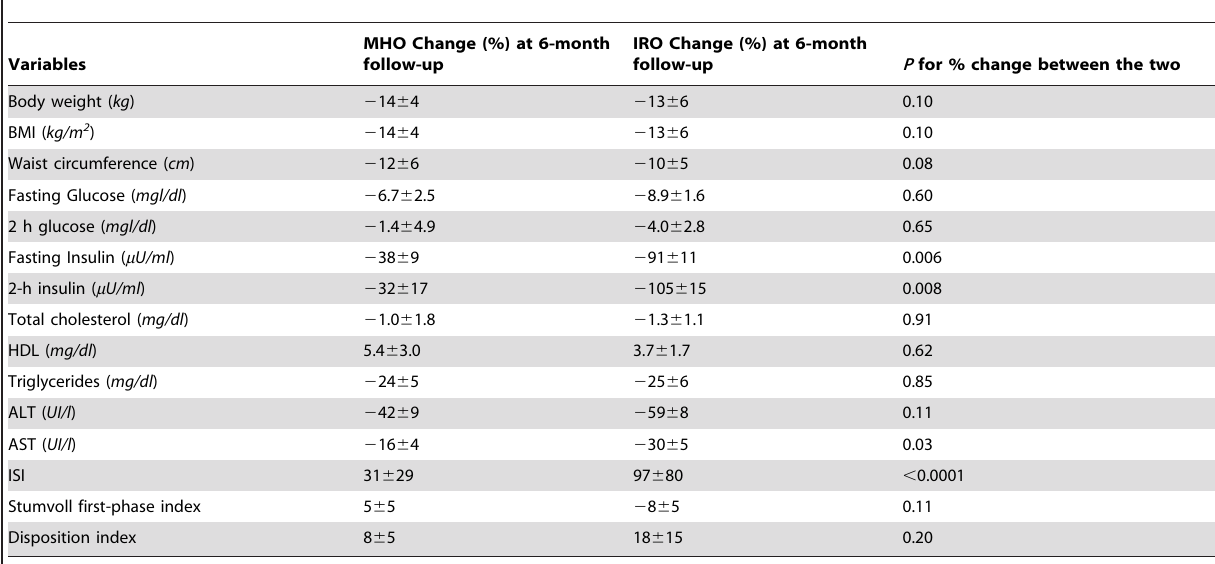
Table 2. Change (%) in clinical characteristics and laboratory data at 6-month follow-up after LAGB intervention in MHO and IRO subjects.